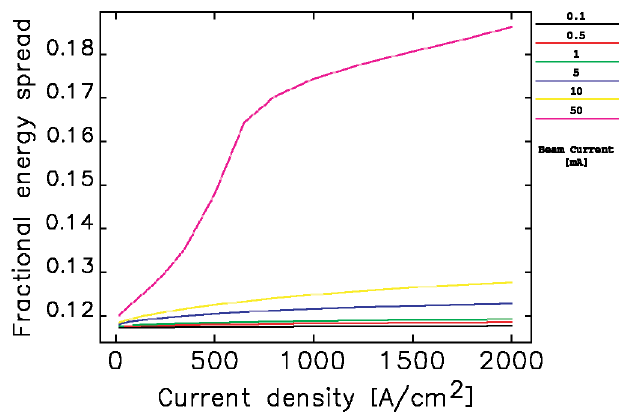
FIG. 11. (Color) rms fractional energy spread as a function of time-average current density, for various beam currents.